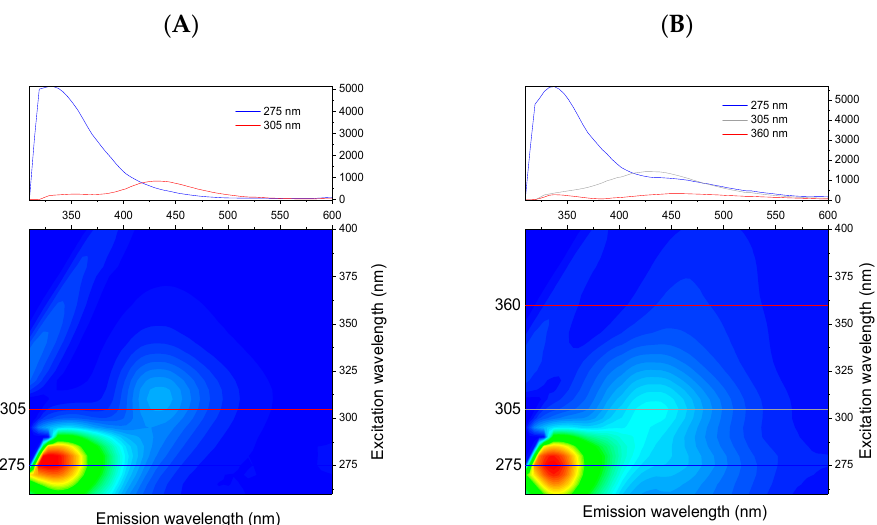
Figure 2. Contour maps of average EEMs for: ( A ) direct juice, ( B ) processed commercial beverages. For most of the studied products, two distinct emission bands were observed. The first band has an excitation maximum at about 275 nm and an emission maximum in the range of 320–360 nm. For the second band, the excitation maximum is located in the range of 290–320 nm, and the maximum emission occurs in the range of 390–460 nm. The average spectra for the two groups of juices revealed that the fluorescence of processed juices extended to longer excitation and emission wavelengths compared to the direct juices. Based on data from the literature, strawberry beverage emission can be related to various classes of phenolic compounds [3,33,34]. For the detailed characterization of fluorescence properties, we analyzed the EEMs using the PARAFAC method. The aim of the analysis was to extract information about the fluorescent compounds contained in strawberry products. Models with a various number of components (from 3 to 5) were analyzed, and the characteristics of these models are presented in Table S2 (Supplementary Materials). The model with four components was selected as optimal based on the core consistency criteria [24]. A high value of this parameter (93%) indicated the suitability of the selected model. The stability of the four-component model was further validated by means of a split-half analysis, where the data set was divided into half for a comparison of similarity. In the data set studied, the similarity measure of two splits was 76.3%. The parameters of the PARAFAC model with four components are shown in Table 1. Table 1. Results of parallel factor analysis (PARAFAC) of EEMs of strawberry beverages. Component No. λ exc / λ em